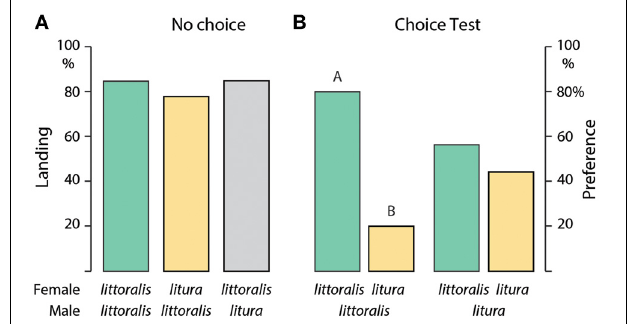
FIGURE 1 | (A) Upwind flight attraction and landing of male Spodoptera littoralis ( n = 50) and S. litura ( n = 20) toward conspecific and heterospecific calling females in a no-choice wind tunnel test. (B) Dual-choice walking bioassay of S. littoralis and S. litura males in presence of conspecific and heterospecific calling females ( n = 25, exact binomial test). Columns with different letters are significantly different at p < 0 . 05.